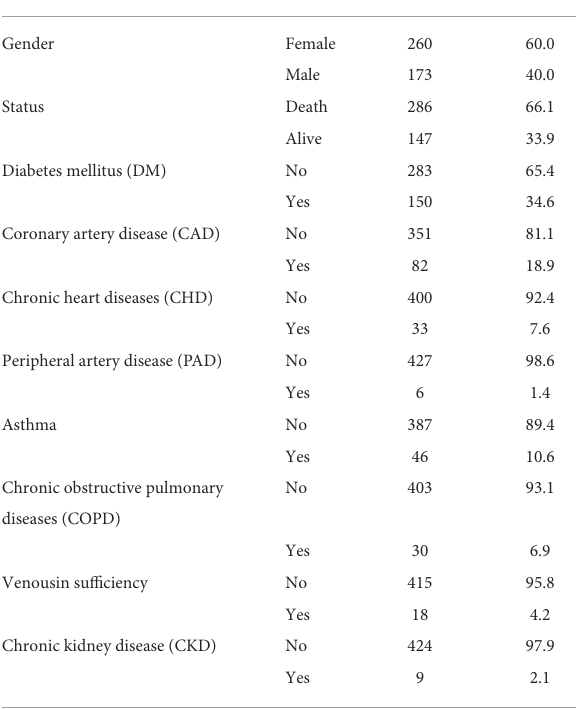
TABLE 1 Descriptive statistics of demographic features and comorbities of patients.